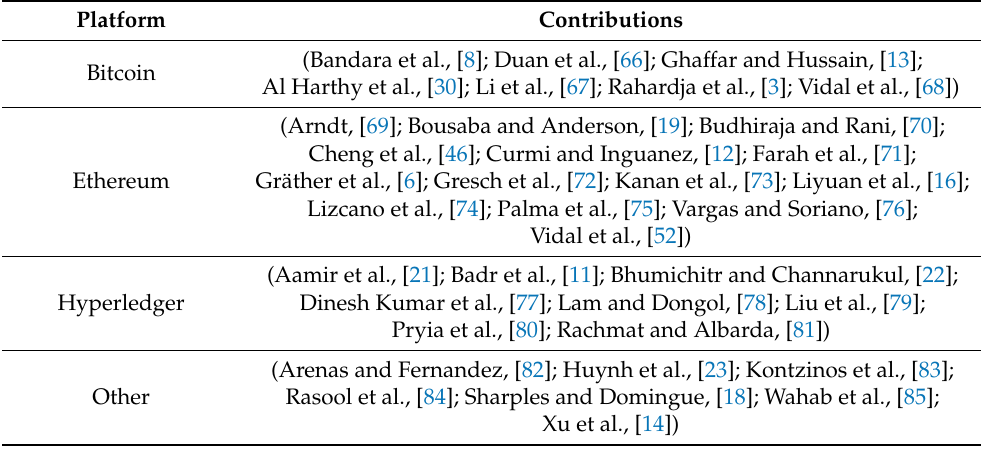
Table 3. The platform used in the prototypes.